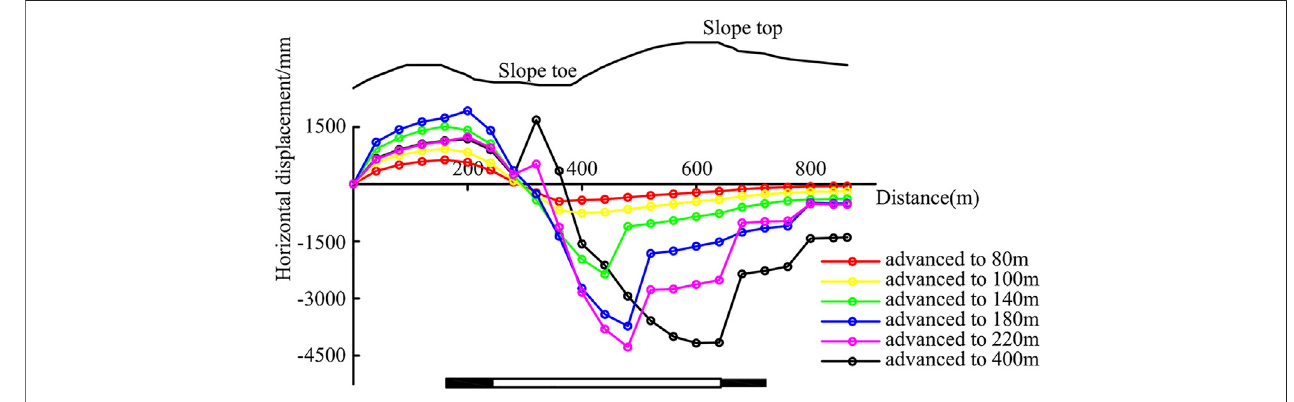
FIGURE 11 | Surface horizontal displacement curve.